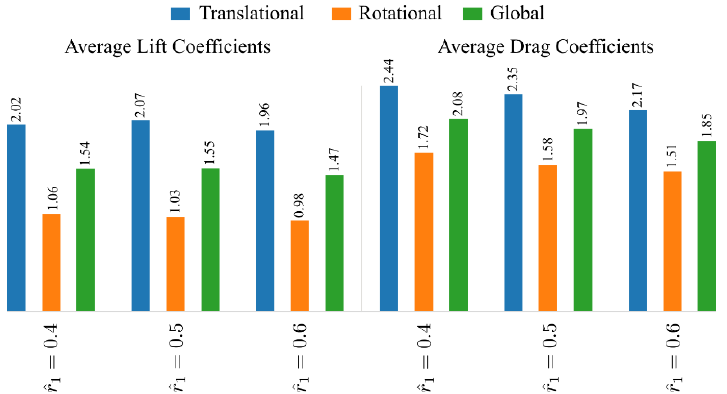
Figure 12. Average lift and drag coefficients for the translational phase, rotational phase, and the whole/global wing stroke, for the different dimensionless radial centroid locations.